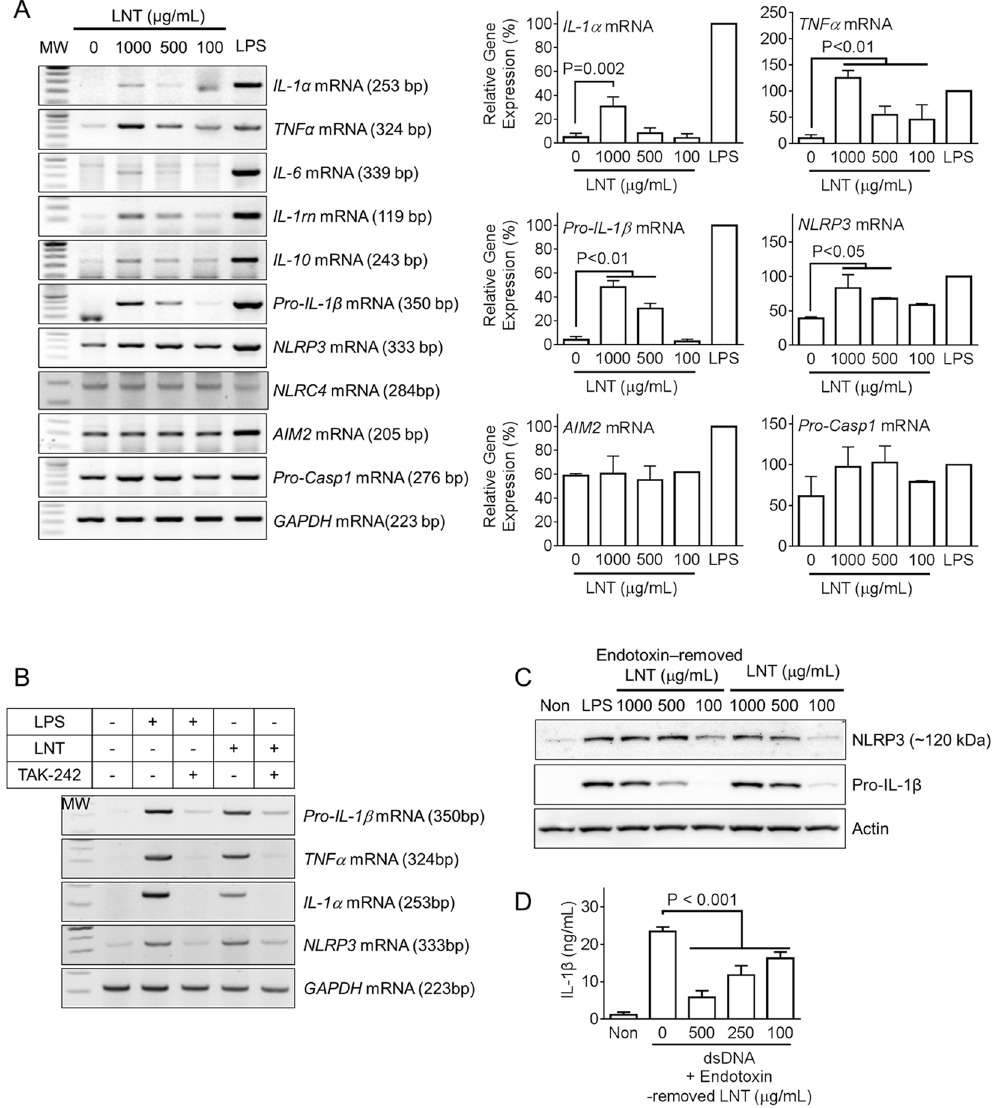
Figure 3. Effect of lentinan on expression of cytokine and inflammasome components. ( A ) BMDMs were treated with the indicated dosage of lentinan (LNT) or LPS (10 ng/mL). Expression of IL-1 α , TNF α , IL-6 , IL-1rn , IL-10 , Pro-IL-1 β , NLRP3 , NLRC4 , AIM2 , and Pro-Casp1 mRNAs was measured by RT-PCR and the right bar graph indicates relative band density. ( B ) BMDMs were treated with LPS (10 ng/mL) or LNT (1 mg/ mL) with/without TAK-242, TLR4 inhibitor. Indicated gene expression levels were assessed by RT-PCR. ( C ) BMDMs were treated with LNT purified by endotoxin removal resin (Endotoxin-removed LNT) or intact LNT as indicated. NLRP3 and Pro-IL-1 β proteins were measured by immunoblotting. ( D ) LPS-primed BMDMs were treated with endotoxin-removed LNT with/without dsDNA. Secretion of IL-1 β was measured by ELISA. All RT-PCR data shown are representative of at least three independent experiments. Bar graph presents the mean ±